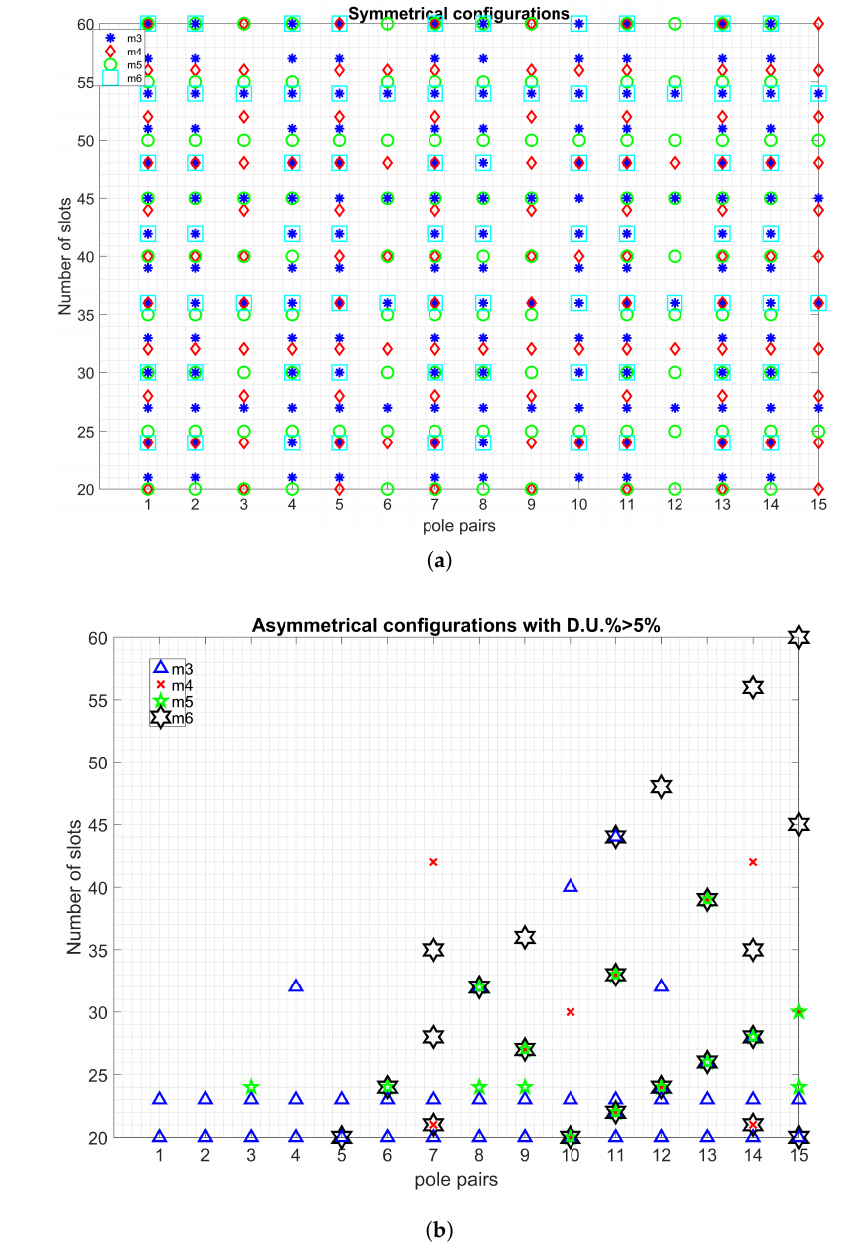
Figure 2. Mapping, for m = 3 ÷ 6, of the ( a ) symmetrical configurations and ( b ) asymmetrical configurations with D . U .% > 5%